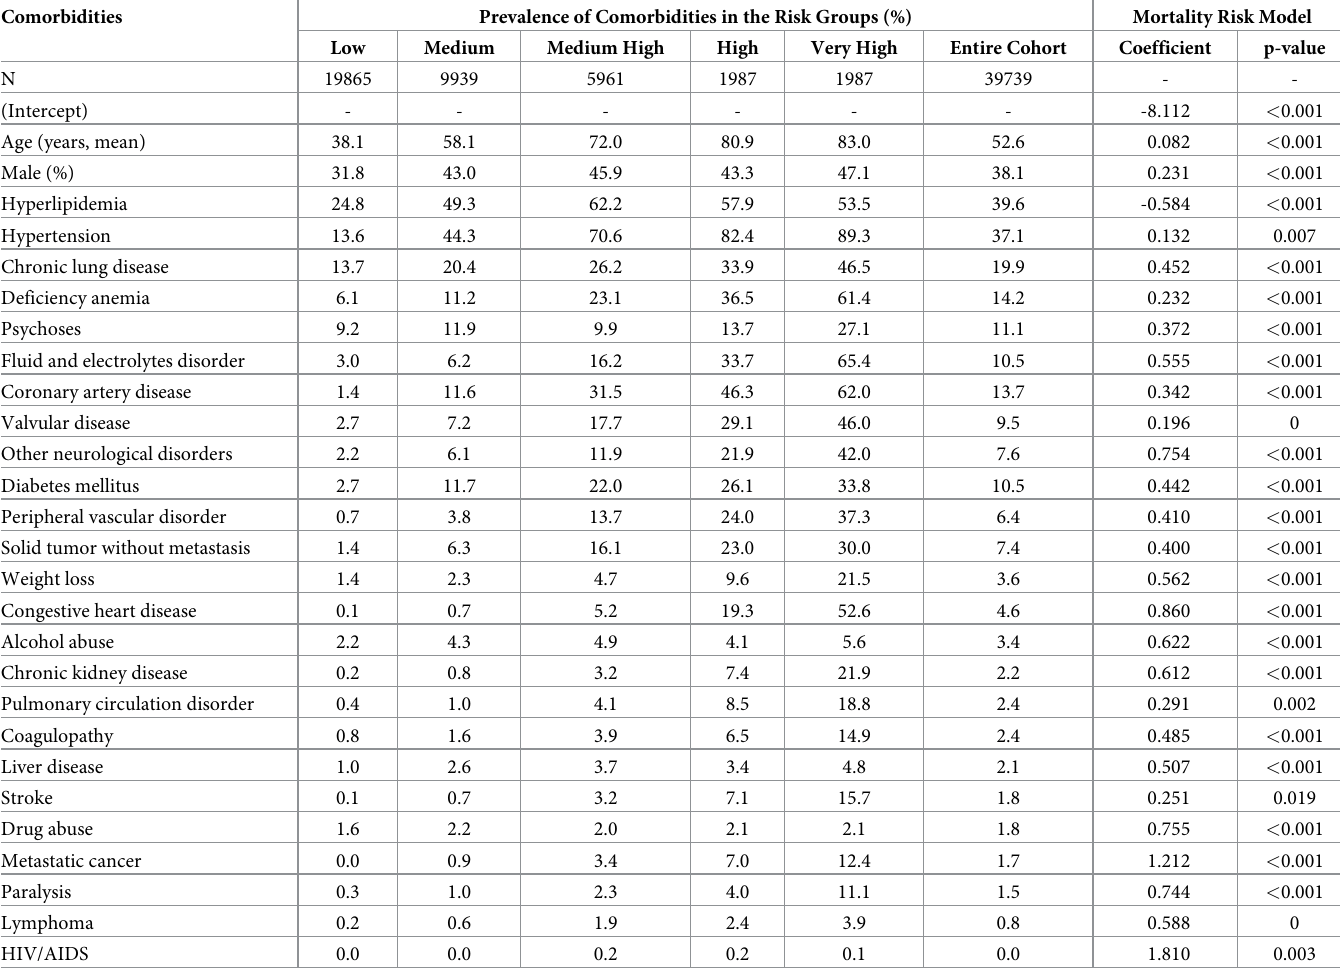
Table 1. Baseline comorbidities and mortality risk